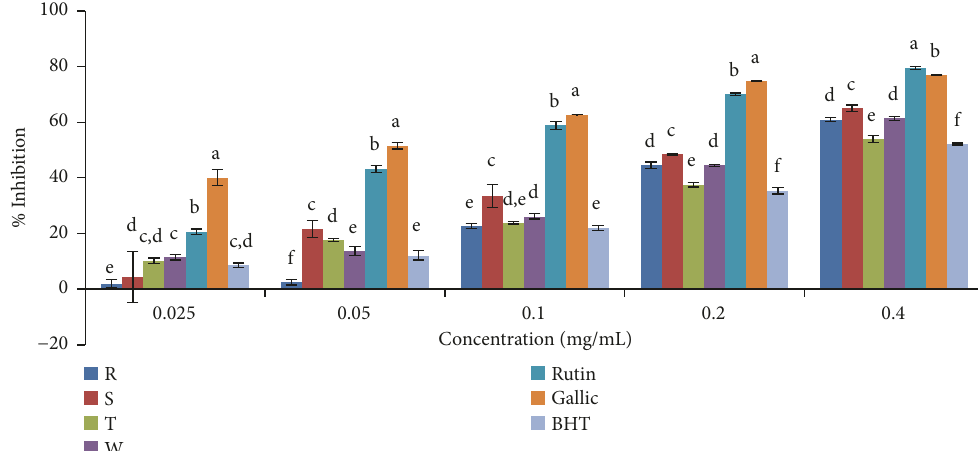
Figure 9: Total antioxidant capacity of aqueous extract of the four varieties of Capsicum species. Values are mean ± SD of three replications. Set of bars having different letters are significantly different at (p < 0.05). R= C. annuum var. abbreviatum , S= C. annuum var. acuminatum , T= C. annuum var. grossum , and W= C. frutescens var . baccatum .